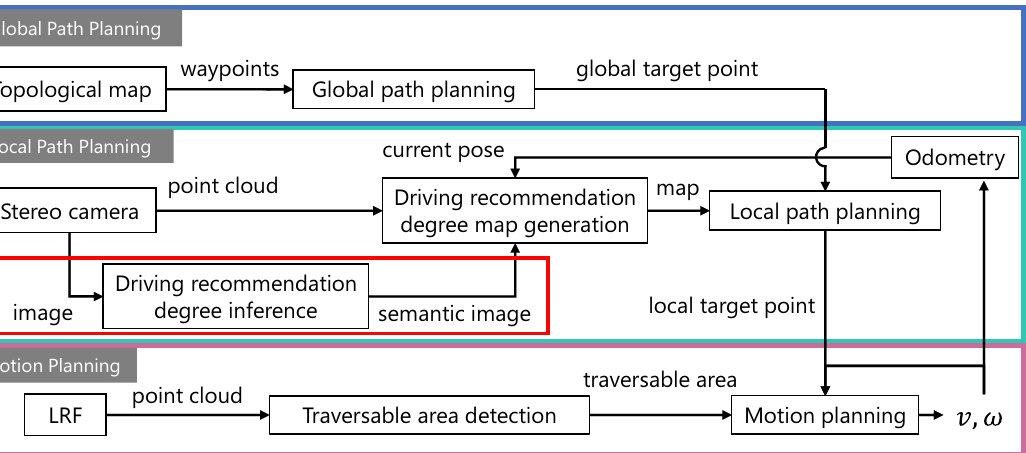
Figure 2. Diagram for overall navigation system using topological map and driving recommendation degree